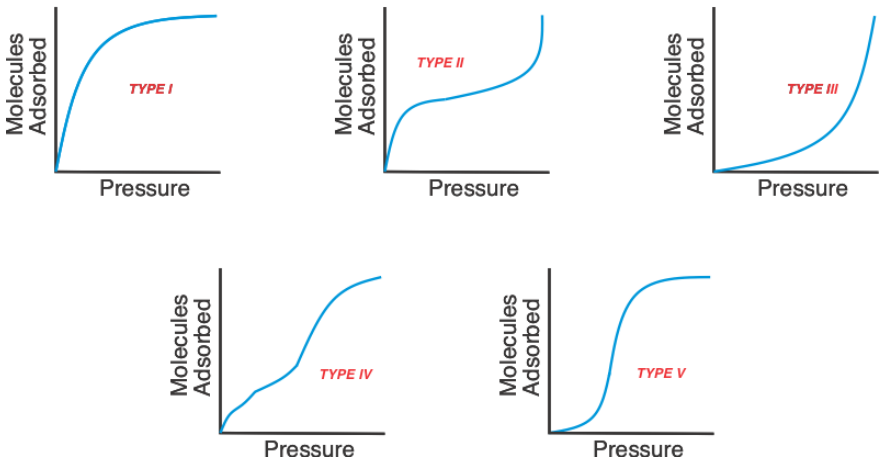
Figure 1. The five types of adsorption isotherms in the classification of Brunauer, Emett and Teller. Adapted from Brenner, 2013 [13].